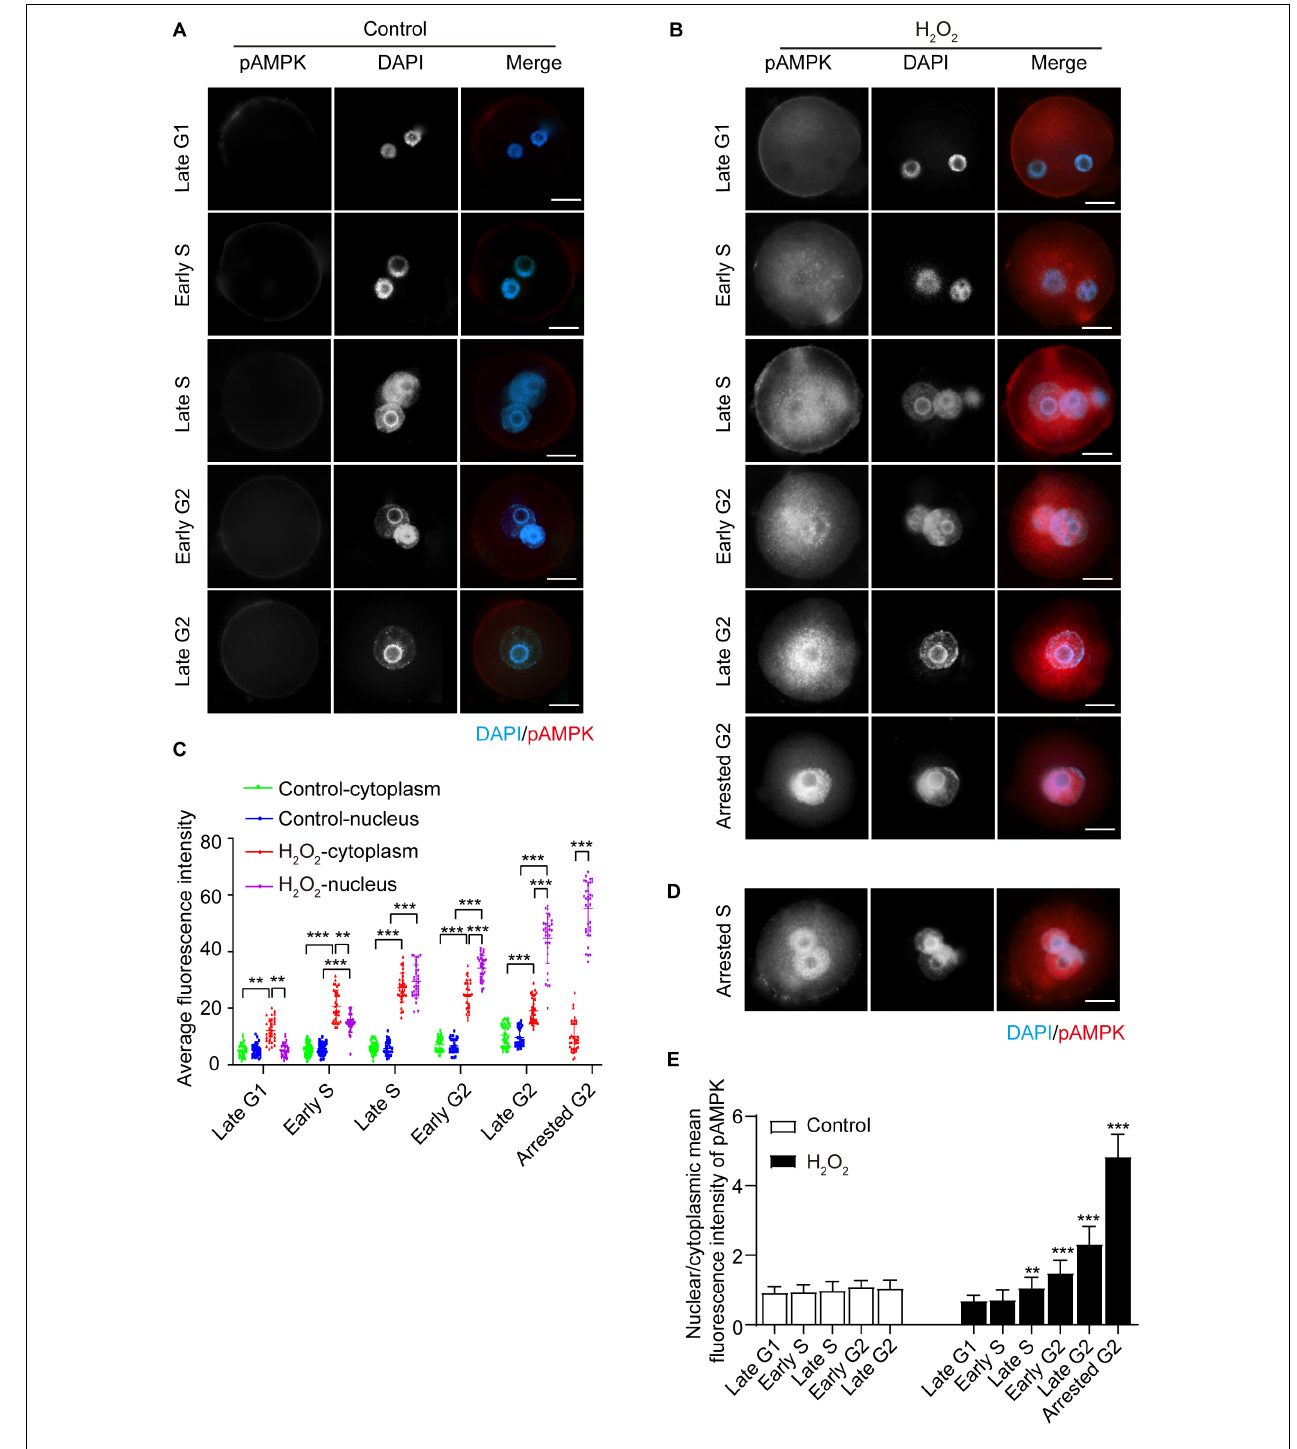
FIGURE 2 | Subcellular distribution and presence of phosphorylated AMPK (pAMPK). pAMPK immunostaining (red) was visualized at different stages during mouse zygote interphase. Nuclei were stained with DAPI (blue). (A) Control zygotes. Scale bar = 20 µ m. (B) H 2 O 2 -treated zygotes. Scale bar = 20 µ m. (C) Mean fluorescence intensity of nuclear and cytoplasmic pAMPK in both control and H 2 O 2 -treated zygotes at different stages during interphase. N = 35 zygotes per group at each stage. (D) pAMPK immunostaining in H 2 O 2 -treated zygotes arrested in the S phase. Scale bar = 20 µ m. (E) Changes in the nuclear/cytoplasmic ratio of the mean fluorescence intensity of pAMPK in control and H 2 O 2 -treated zygotes. N = 35 zygotes per group at each stage. ** p < 0.01; *** p < 0.001 compared to late G1 phase within the group. Results in (C,E) were analyzed by one-way ANOVA and Tukey’s test. ** p < 0.01; *** p < 0.001. Error bars: SD.